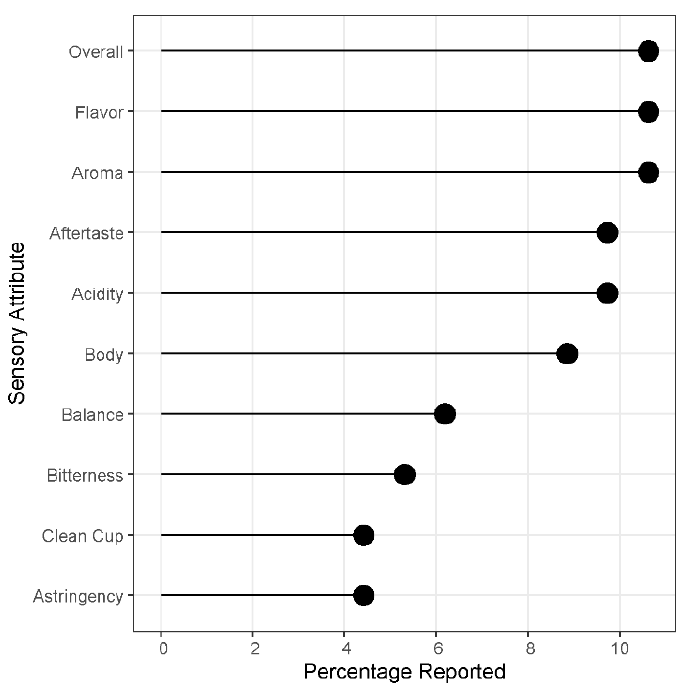
Figure 2. The top eleven sensory attributes used for assessing overall sensory quality across the reviewed literature. Percentage reported is the number of occurrences of an attribute out of the total number of reported attributes [1,21–40].